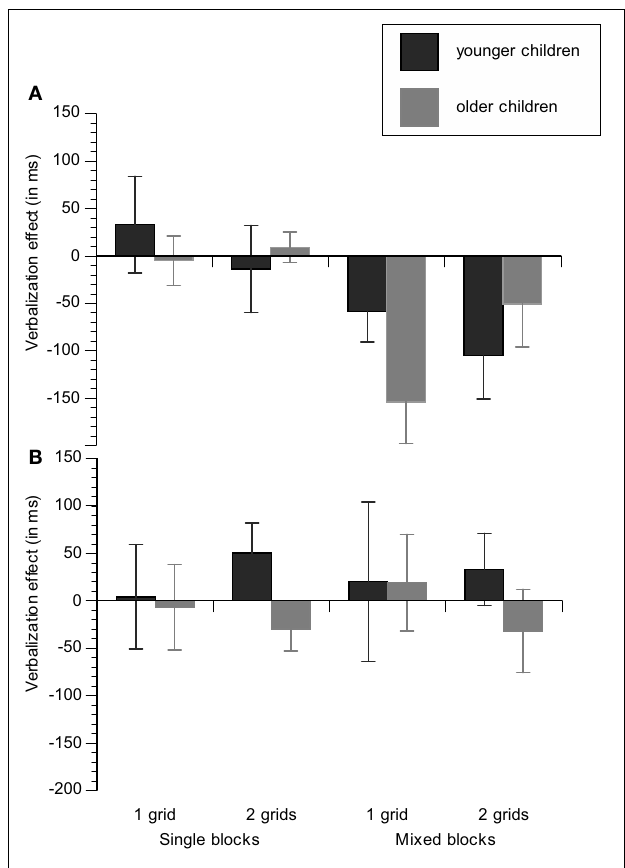
FIGURE 3 | Verbalization effects are displayed as a function of age group (younger children/older children), task-sequence load (1 grid/2 grids), and block type (single-task/mixed-task) for the group with practice in task switching (silent condition first) (A) and the group without practice in task switching (verbalization condition first) (B) .